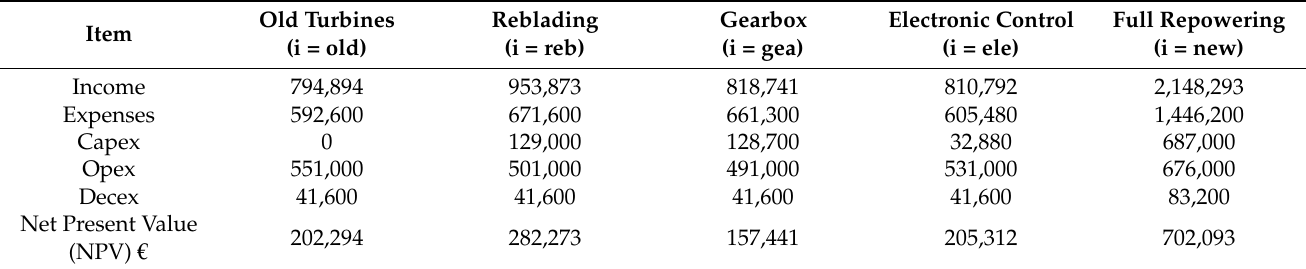
Table 11. Net Present Value calculation ( € ).